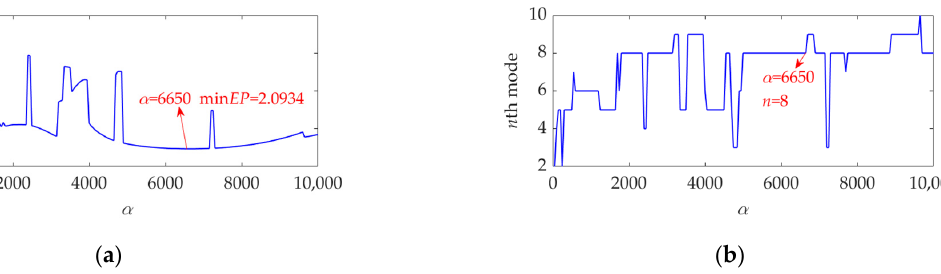
Figure 18. Relationship between the α value and ( a ) the EP index value and ( b ) order number of the target mode at each step of α increase.